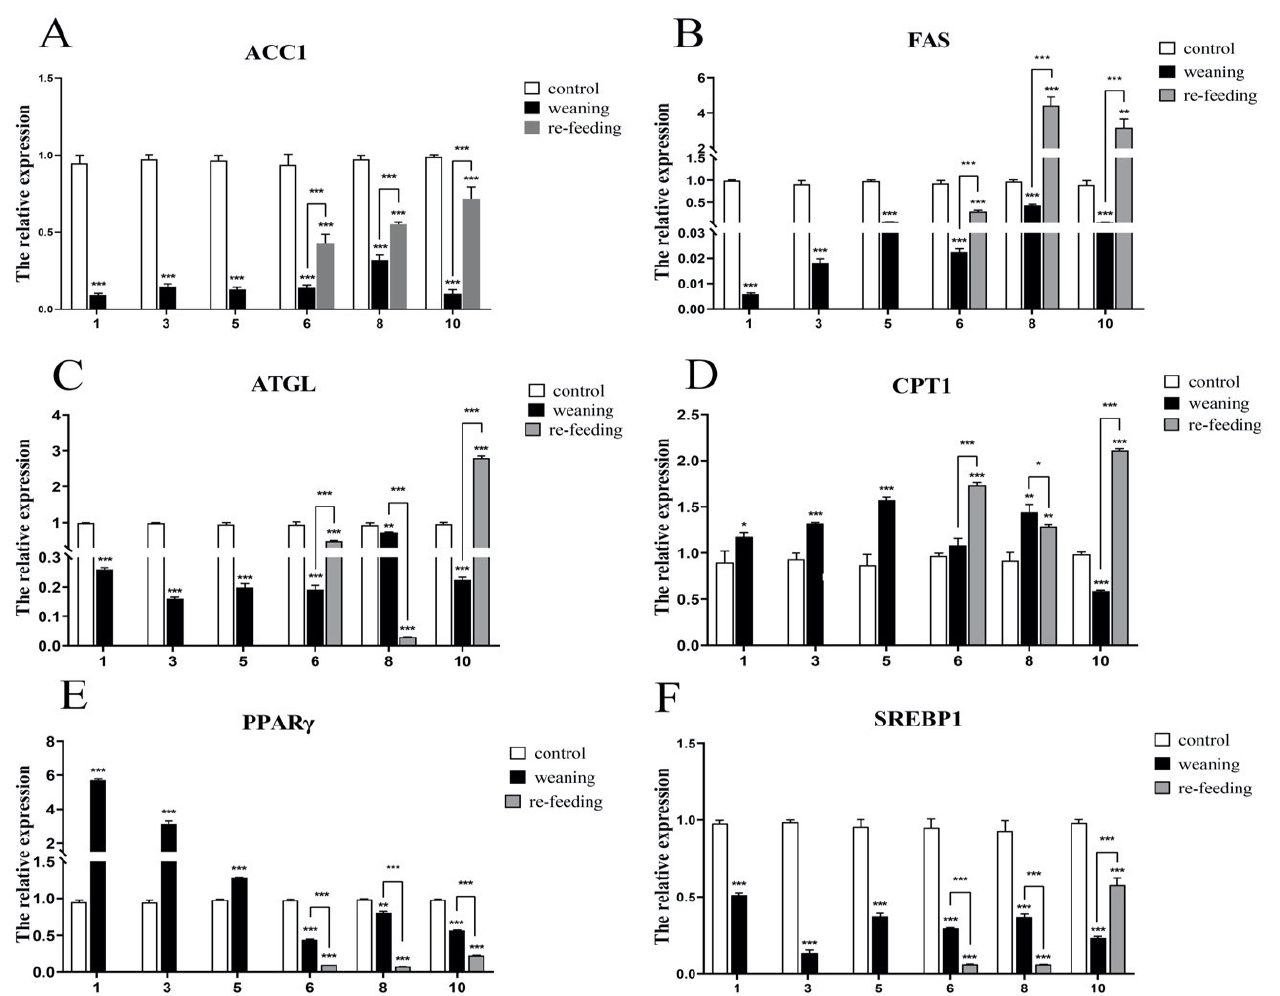
Figure 8. Weaning and refeeding earthworms induced changes in mRNA levels of ( A ) ACC1 , ( B ) FAS , ( C ) ATGL , ( D ) CPT1 , ( E ) PPAR γ and ( F ) SREBP1 . Gene-expression levels were normalized to that of β -actin and EF1- α . Data are presented as the group means ± SD ( n = 5). Statistical comparison of the mRNA levels detected at different groups was carried out by t -test of variance (* p < 0.05, ** p < 0.01, *** p < 0.001).